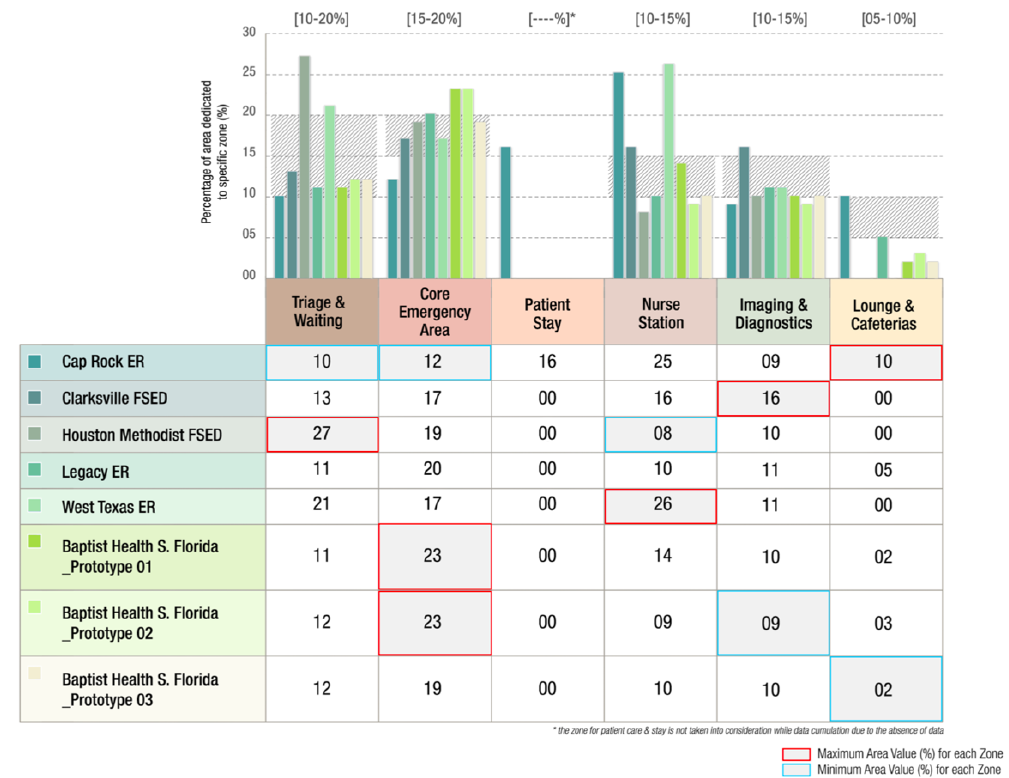
Figure 8. Results from the data analysis of FSED Functional areas.